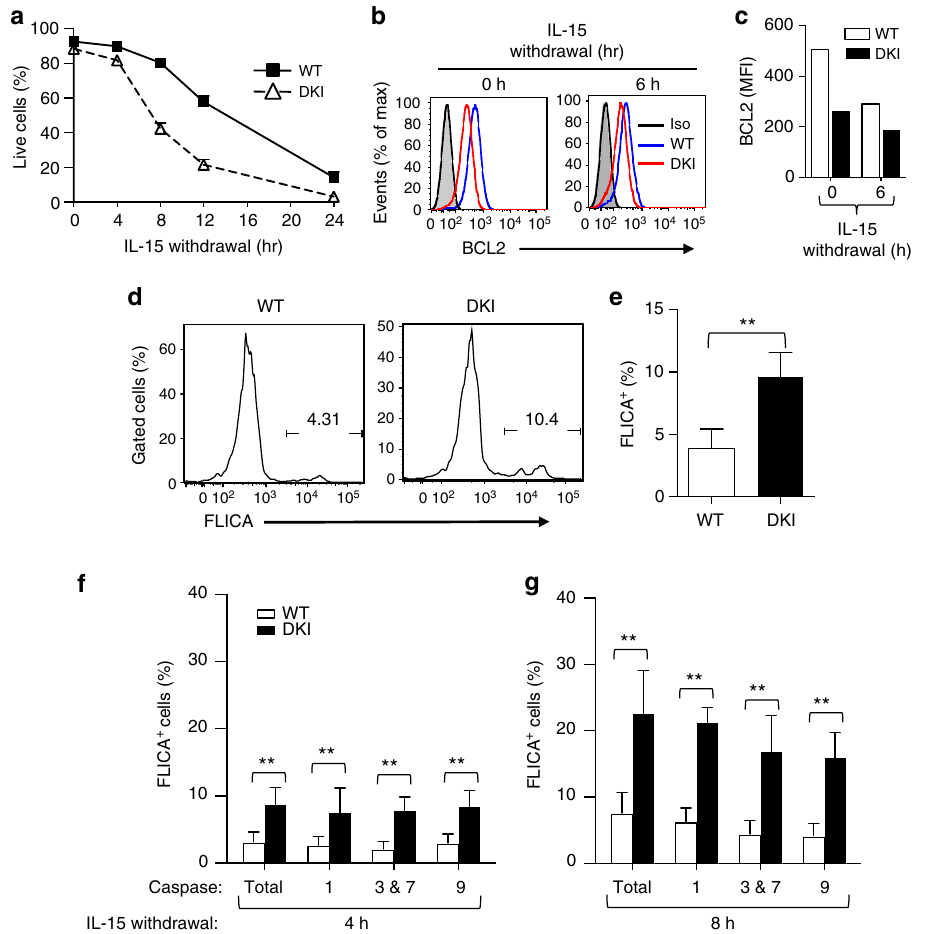
Fig. 6 Dysregulated expression of cell survival-related genes and increased active caspase levels in Stat5 DKI NK cells. a Time course of the percentage of viable WT ( fi lled squares) or Stat5 DKI (open triangles) NK cells following IL-15 withdrawal. Cells were isolated from spleen and cultured in vitro with IL-15 for 6 days prior to withdrawal. Three WT and Stat5 DKI mice were used. The experiment was performed twice. Error bars are means ± SEM and statistical analyses were performed by grouped multiple t -test using Prism 7.0b. b Histograms of intracellular BCL2 staining of WT (blue) and Stat5 DKI (red) NK cells. Staining was of cells cultured in 20 ng ml − 1 IL-15 (0 h) or 6 h upon IL-15 withdrawal. c Summary of BCL2 levels (MFI) before (0 h) and after IL-15 withdrawal for 6 h. d Representative FLICA staining of freshly isolated splenic NK cells. The numbers in the gated regions are FLICA + NK cells (%). e Summary of d of freshly isolated splenic WT (open bar) and Stat5 DKI NK ( fi lled bar) cells analysed using the FLICA Poly Caspase Assay kit. Error bars are means ± SEM and statistical analyses were performed by grouped multiple t -test using Prism 7.0b. f Summary of FLICA staining of WT (open bars) and Stat5 DKI (closed bars) NK cells at 4 h after IL-15 withdrawal for poly caspases (Total), caspase-1 (1), caspases-3 and 7 (3, 7), and caspase-9. Error bars are means ± SEM and statistical analyses were performed by grouped multiple t -test using Prism 7.0b. g Summary of FLICA staining of WT (open bars) and Stat5 DKI (closed bars) NK cells at 8 h after IL-15 withdrawal for poly caspases (Total), caspase-1 (1), caspases-3, 7 (3, 7), and caspase-9. Error bars are means ± SEM and statistical analyses were performed by grouped multiple t -test using Prism